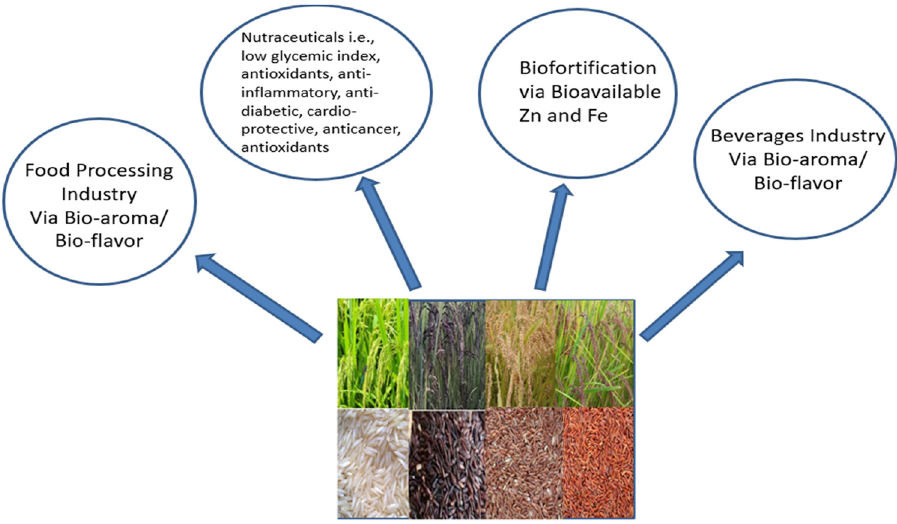
Figure 3: Application of di ff erent aromatic Asian rice